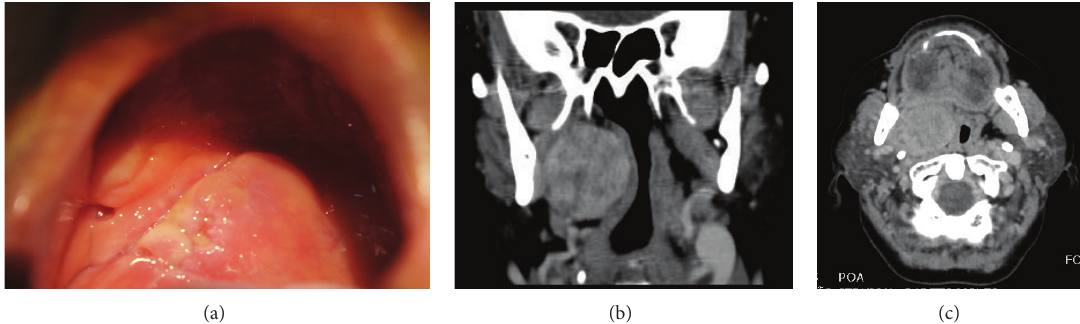
Figure 1: Nodular lesion on right side of soft palate lined by normal mucosa (a). Axial (b) and coronal (c) computed tomography scans showing a hyperdense expansive lesion with well-defined limits measuring 3.7 × 3.3 cm, determining compression and displacement to the left part of the nasopharynx and oropharynx, and causing narrowing of the airways.